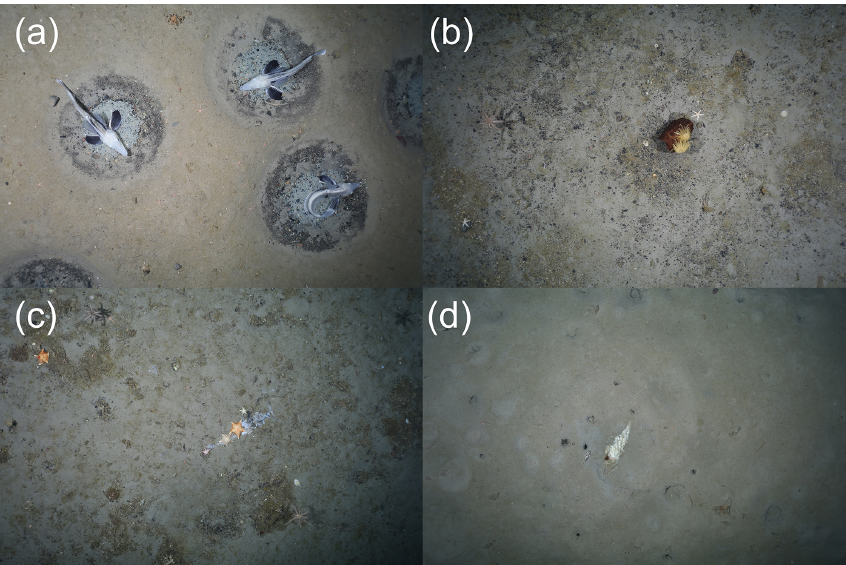
Figure 7. Typical seafloor images collected from each of the OFOBS surveys made of the northern Filchner Trough seafloor dur- ing RV Polarstern cruise 124. (a) Station PS124_21-7, HOTKEY_2021_02_16 at 04_05_34 IMG_0112.JPG, (b) Station PS124_26-07, TIMER_2021_02_17 at 00_43_30 IMG_0124.JPG, (c) Station 30-07, SW_RELEASER_2021_02_18 at 03_26_43 IMG_0667.JPG, (d) Sta- tion PS124_33-04, SW_RELEASER_2021_02_19 at 03_55_18 IMG_0162.JPG. The three red points within each image represent the sizing lasers (50cm spacing). All images are presented here and in the dataset with no manipulation or colour